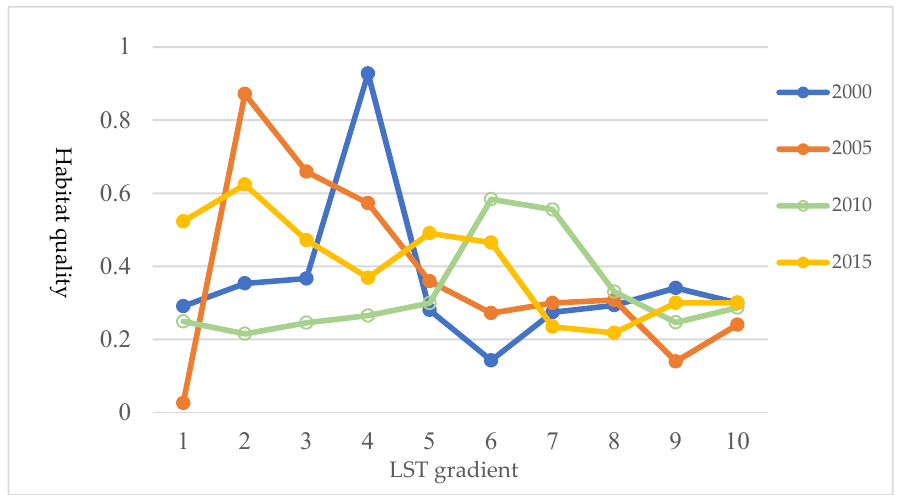
Figure 6. Distribution of habitat quality along LST gradients during the different periods from 2000 to 2015.